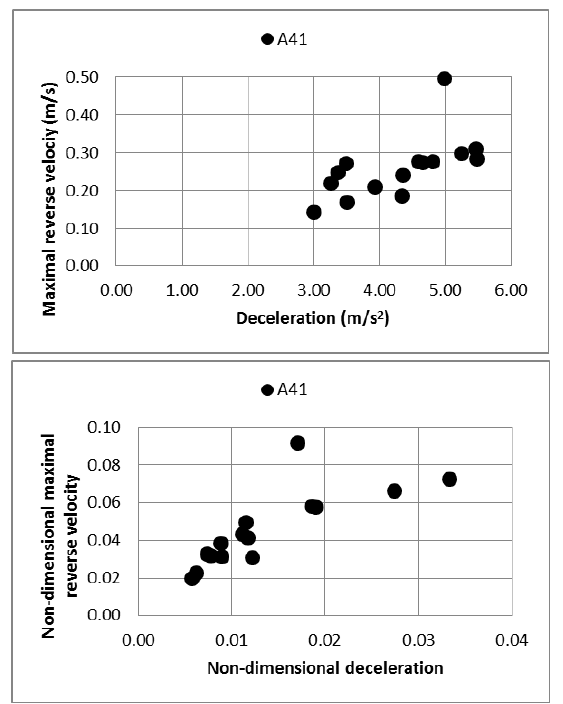
Fig. 16. Dynamic properties – reverse velocity dependence on system deceleration